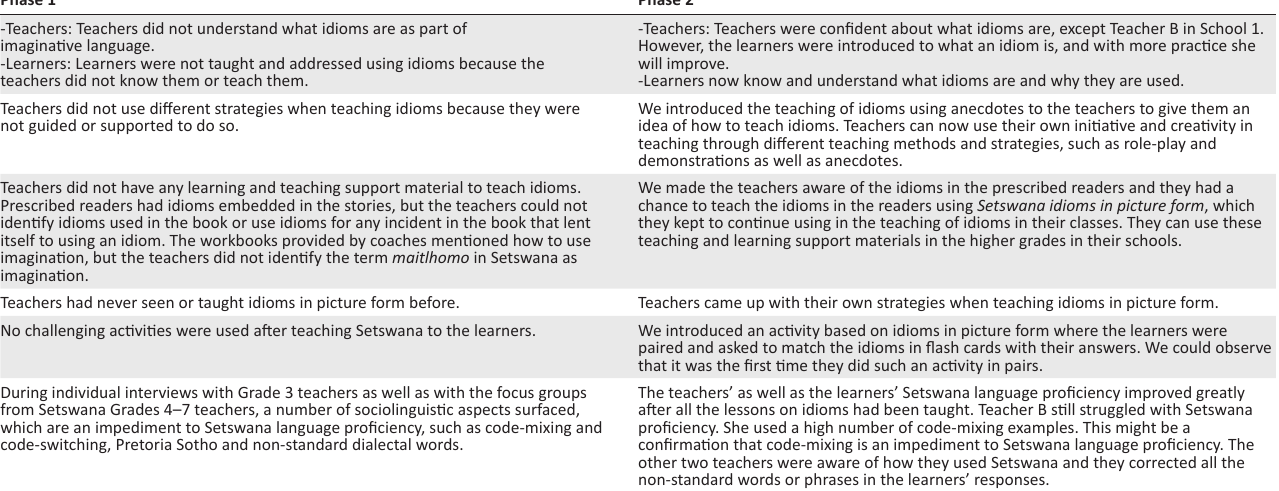
TABLE 2: Comparative analysis of Phase 1 and Phase 2. Phase 1 Phase